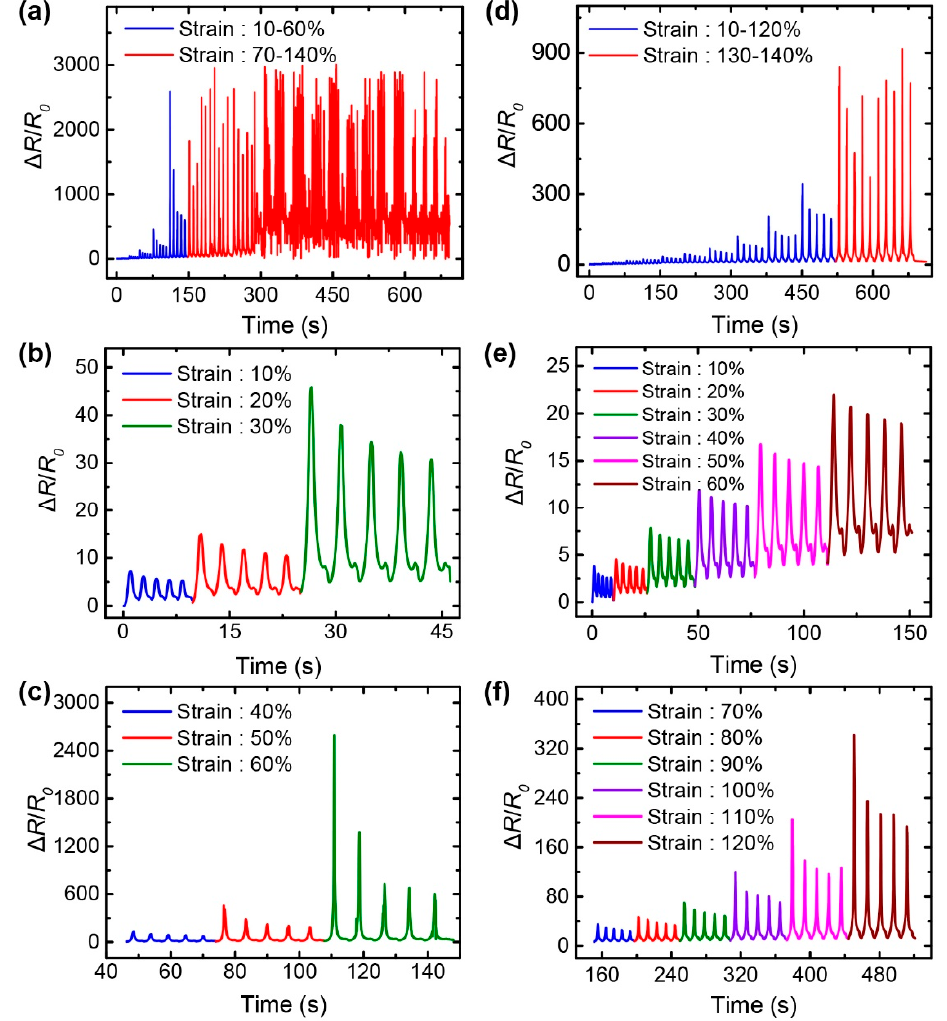
Figure 5. Resistance responses of the: ( a – c ) G/SpX; ( d – f ) G/AgNW/SpX composite strain sensors under various strain levels; ( a , d ) Relative change in resistance of the sensors at strains ranging from 10- to 140%; ( b , c , e , f ) Detailed resistance-strain responses of the sensors at each strain level.